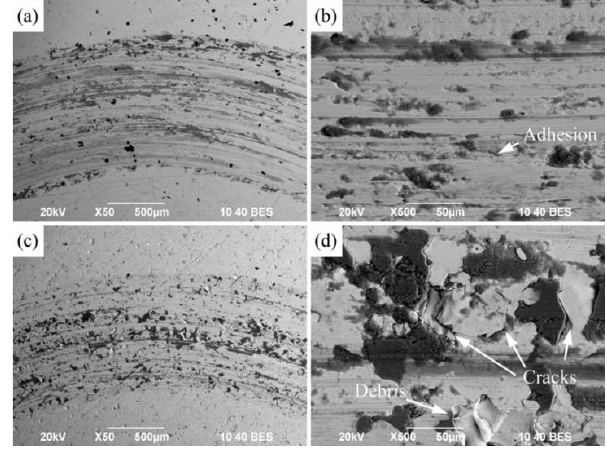
Figure 7. SEM micrographs of grinding crack of the 304 stainless steel and the Fe-Cr-B-C coating after a wear test: ( a , b ) 304 stainless steel; ( c , d ) Fe-Cr-B-C coating.